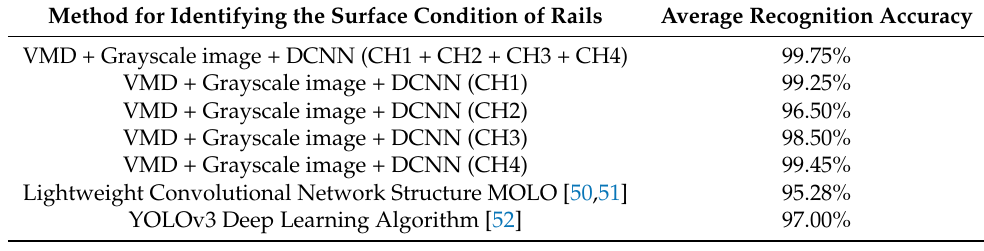
Table 9. Performance of different fault diagnosis methods. Method for Identifying the Surface Condition of Rails